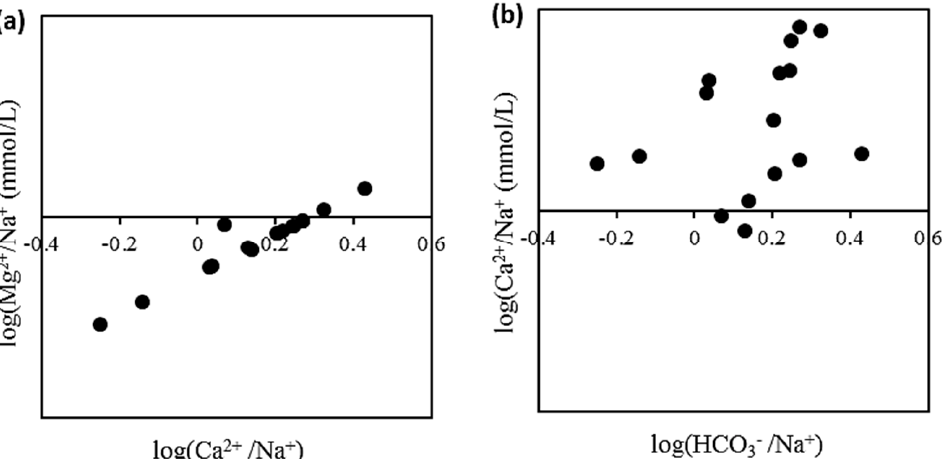
Figure 9. Bivariate plots of ( a ) HCO 3 − vs. Ca 2+ + Mg 2+ ; ( b ) HCO 3 − + SO 42 − vs. Ca 2+ + Mg 2+ ; ( c ) Total cations vs. Ca 2+ + Mg 2+ ; ( d ) Cl − vs. Na + + K + ; ( e ) Cl − vs. Na + ; ( f ) Na + + K + vs. total cation s.